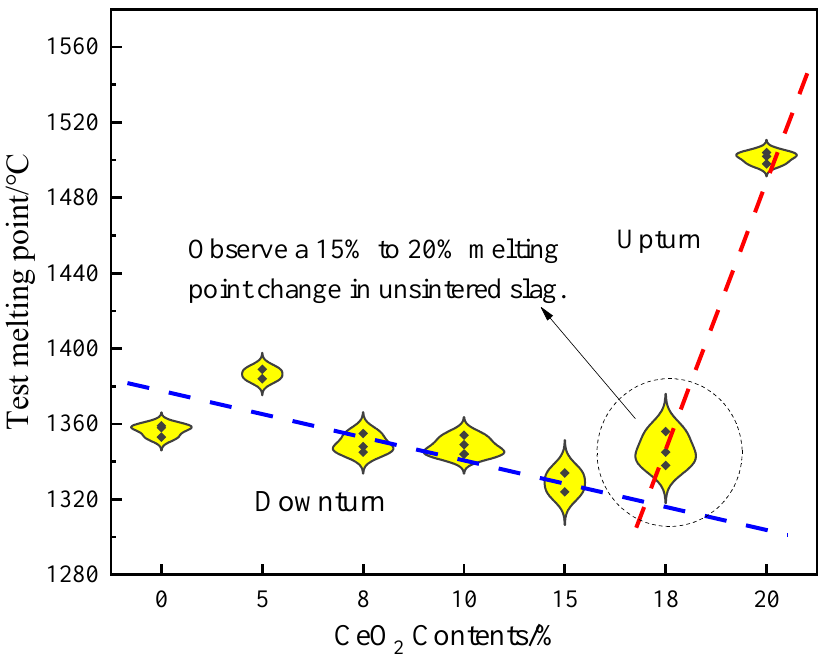
Figure 7. Slag melting-point-change curve.